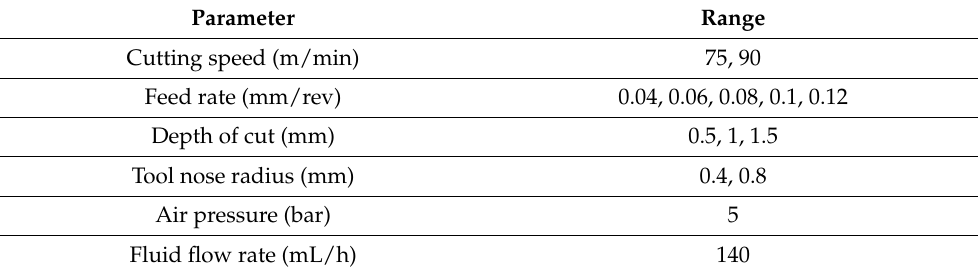
Table 1. Input parameters range values.